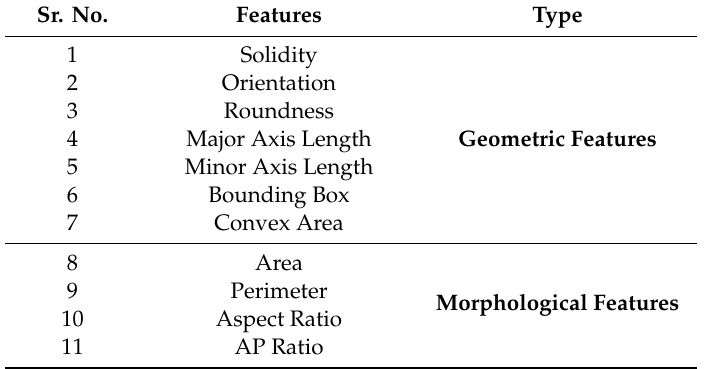
Table 3. Eleven most significant features selected from the global feature list of 27. Sr. No.